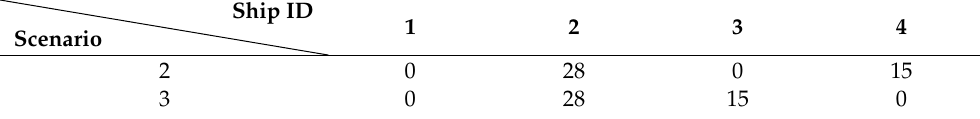
Table 12. Example 2—final cost for Strategy 2a